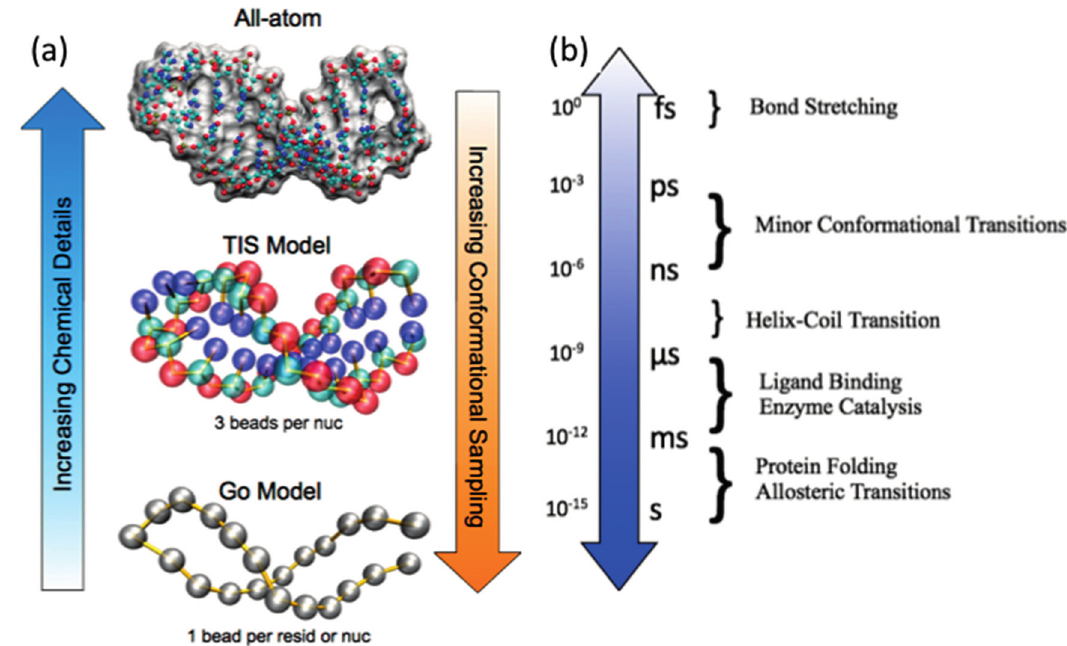
Figure 5. Molecular dynamics approaches at different levels of chemical detail and the associated typical timescales of biomolecular motions. ( a ) The main motivation for developing chemically simplified, coarse-grained approaches is the degree of conformational sampling that results from longer timescales that can be studied; ( b ) The approximate timescales for various biomolecular motions are